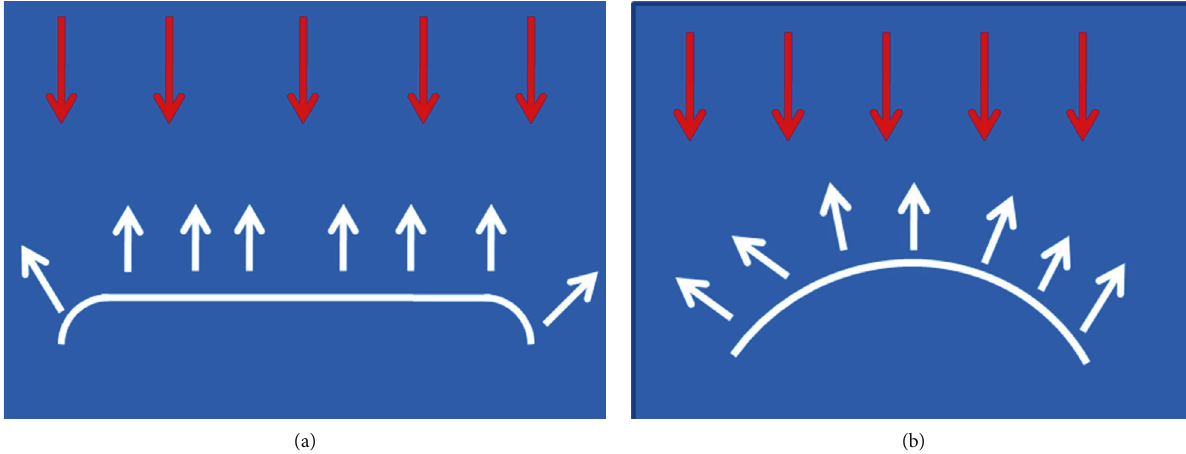
Figure 10: The light incidence on tooth surface leading to optical illusion [10]. (a) Plate surface. (b) Rounded